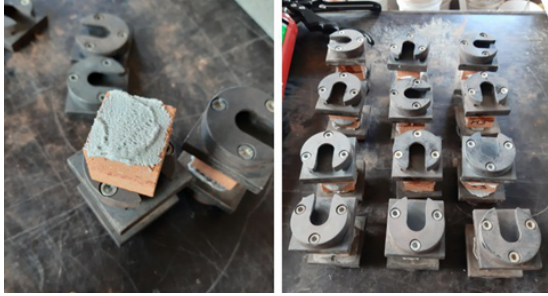
Figure 4. Application of epoxy to samples for fixing steel plates.